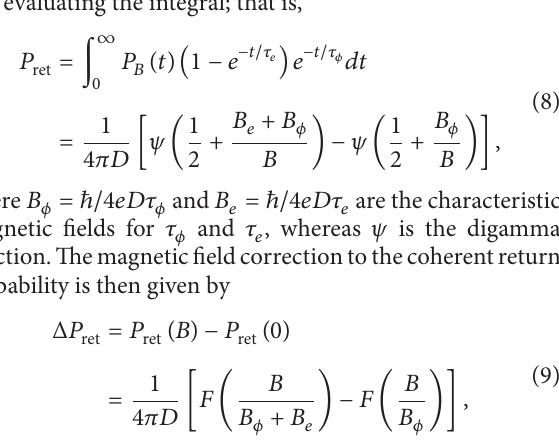
Figure 1: The relative return probability is shown as a function of the magnetic field for the different models. The green curve is from expression (9), the blue curve is from expression (10) with = 50𝐵 𝐵 ⋆ 𝜙 , and the red curve is obtained from expression (19) with = 500𝐵 𝐵 = ∞ . For all curves we assumed that 𝐵 𝐵 0 𝜙 and 1 The inset shows a zoom-in of the region close to zero magnetic